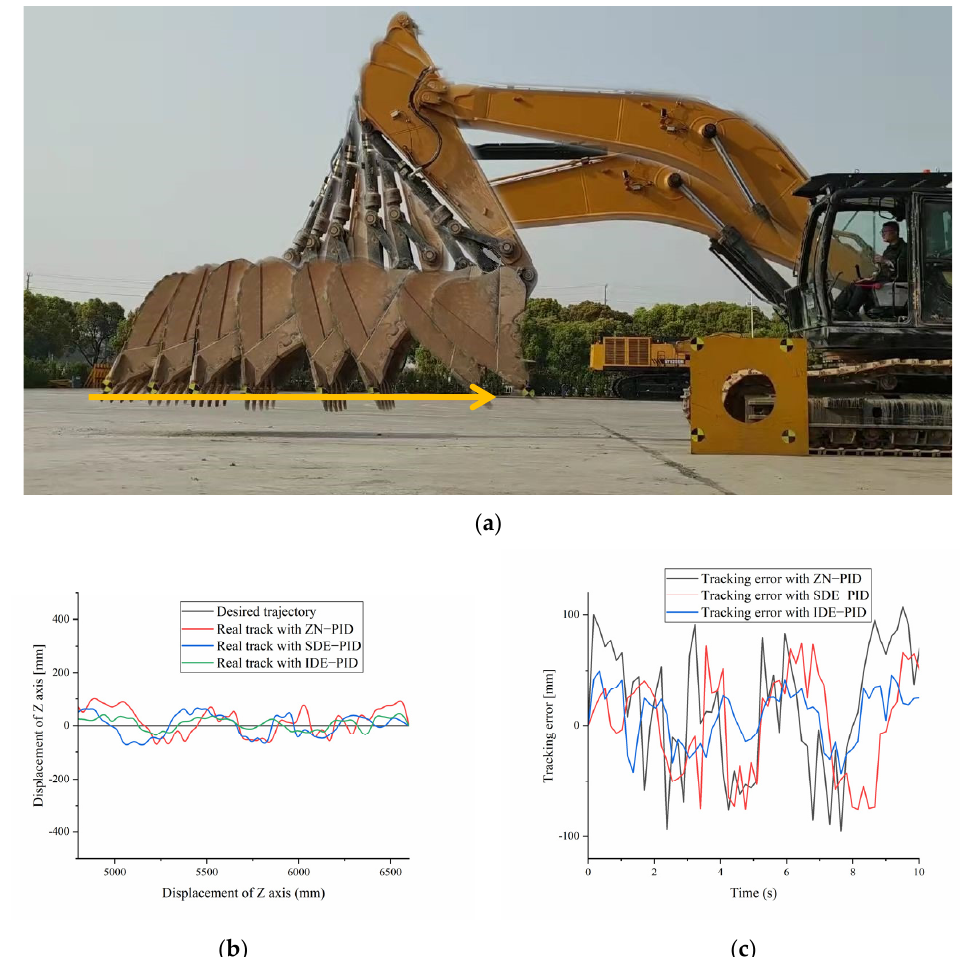
Figure 13. ( a ) Schematic diagram of experimental results (the arrow indicated the leveling opera- tion), ( b ) trajectory tracking results of bucket tip, and ( c ) tracking errors when excavator performs leveling operation.